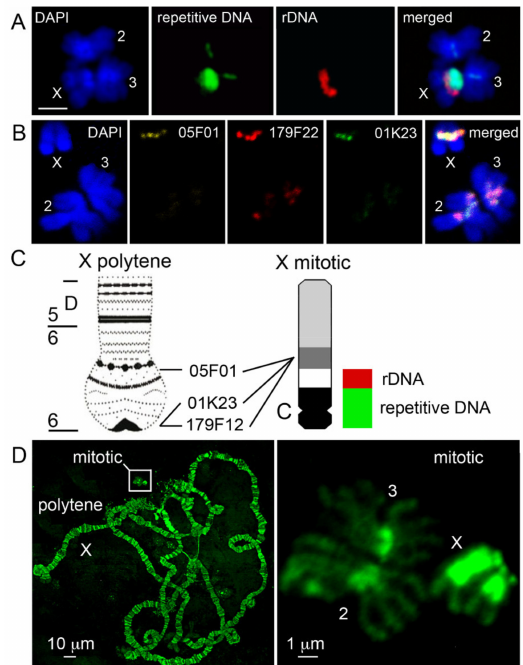
Figure 1. Comparison of the X heterochromatin structure between mitotic and polytene